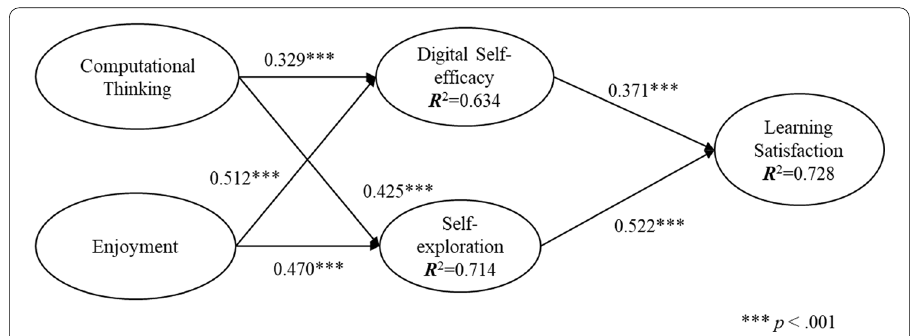
Fig. 2 Results of the research model